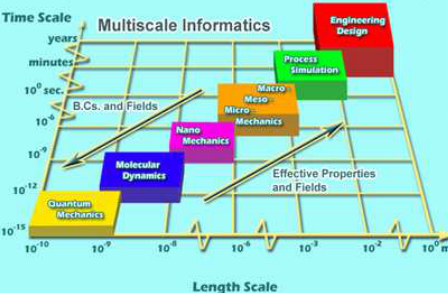
Figure 2. Length and time scales in Hierarchical